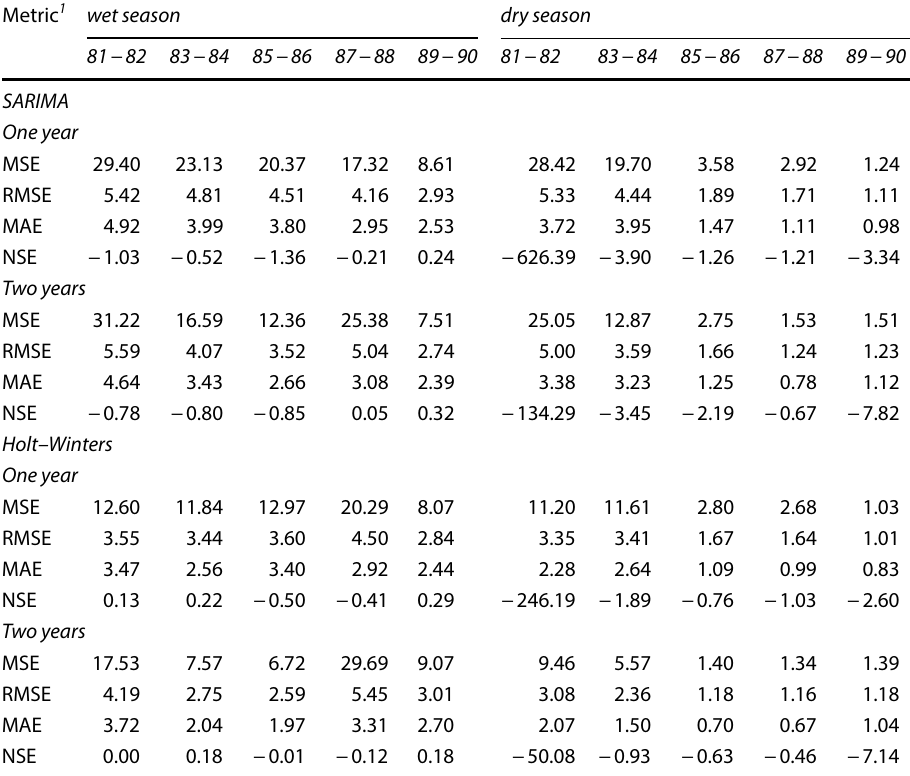
Table 3 SARIMA and HW forecasting errors by